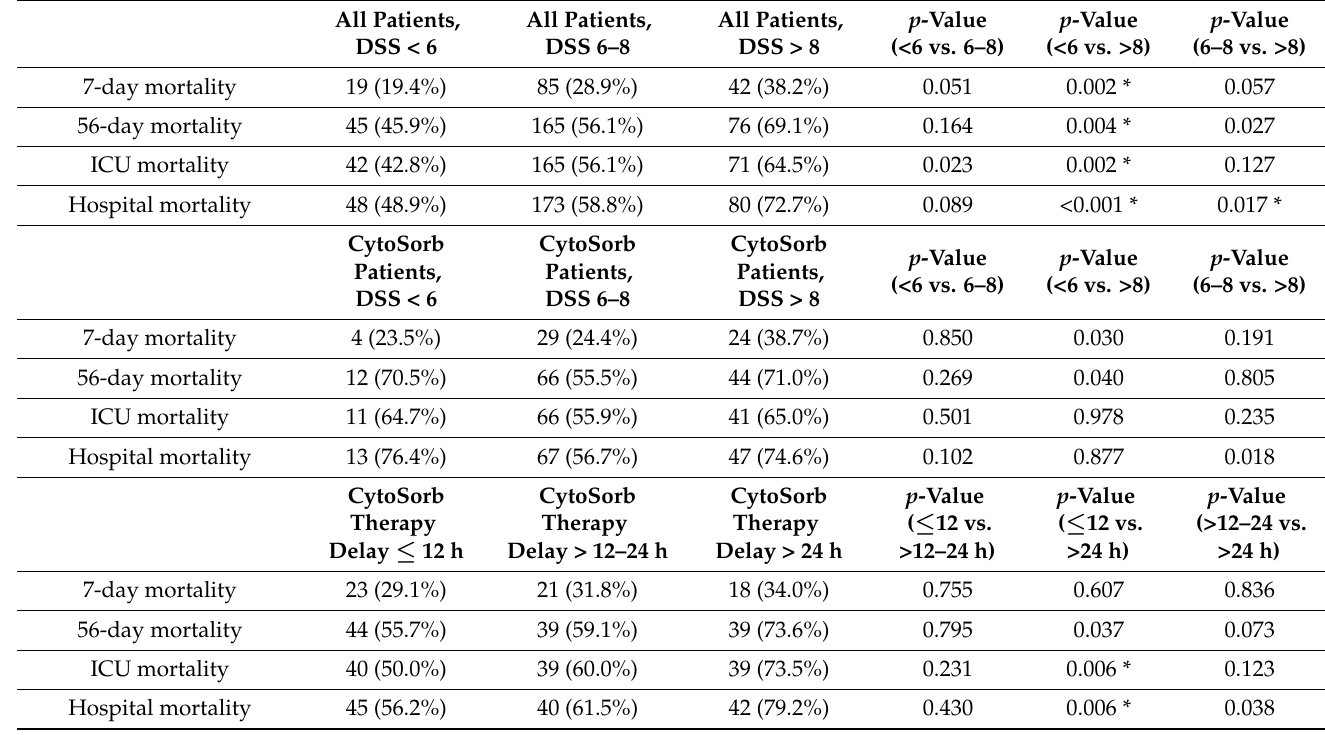
Table 3. Mortality rates in different patient groups. Presented are frequencies, percentages and levels of significance. All